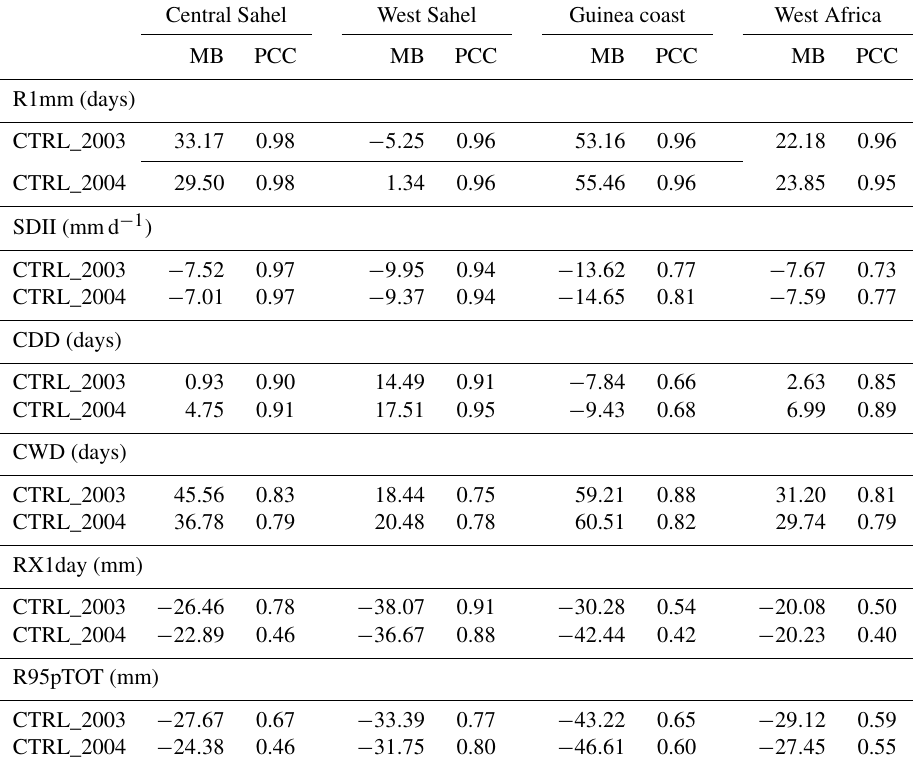
Table 2. The pattern correlation coefficient (PCC) and the mean bias (MB) of the R1mm (in days), SDII (in mmd − 1 ), CDD (in days), CWD (in days), RX1day (in mm) and R95pTOT (in mm) indices for control experiments (initialized with initial soil moisture values from the ERA-20C reanalysis) with respect to CHIRPS calculated over the Guinea coast, Central Sahel, West Sahel and entire West Africa domains for JJAS 2003 and JJAS 2004. Central Sahel West Sahel Guinea